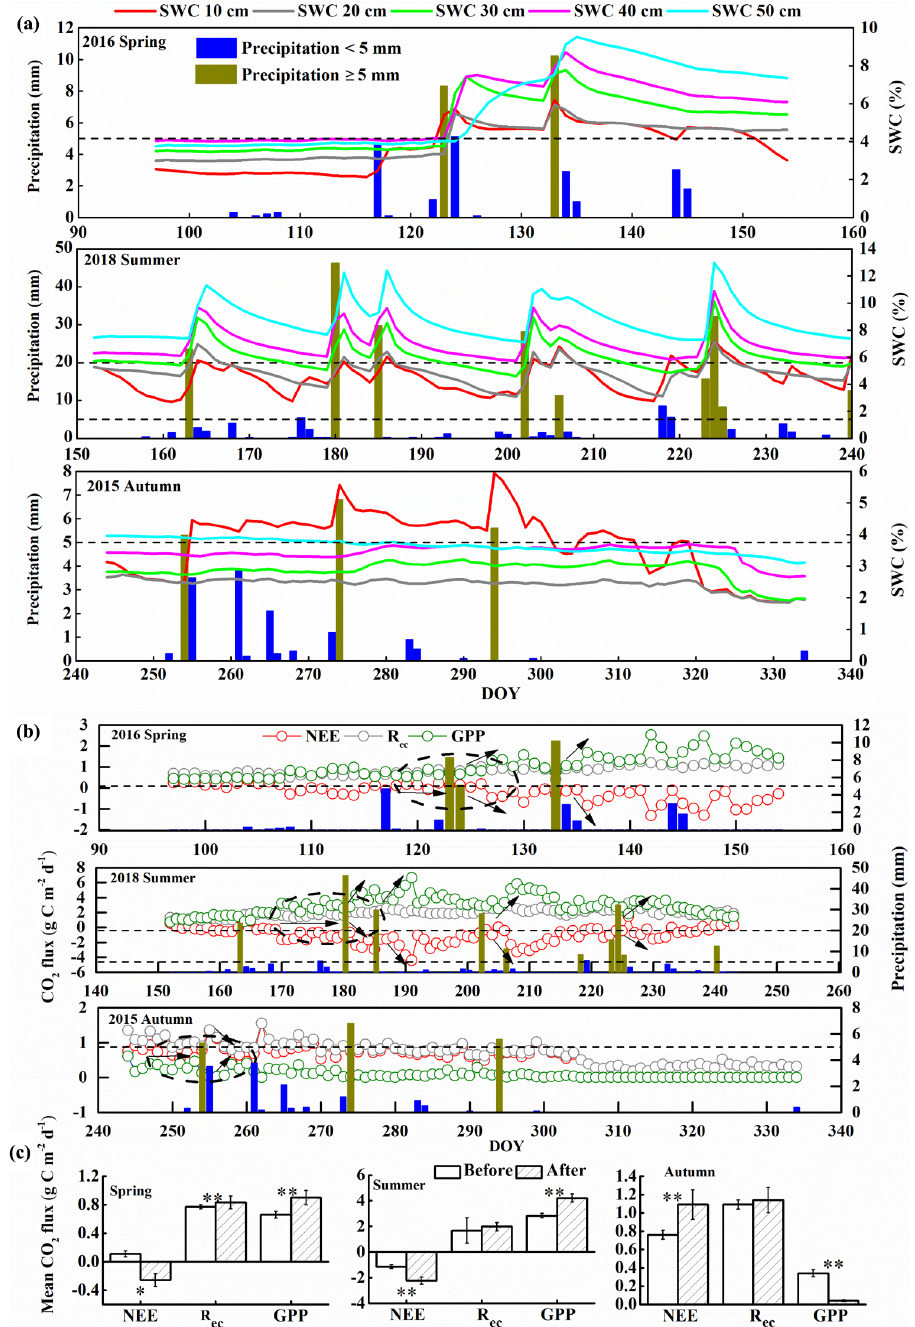
Figure 2. (a) Changes in soil water content (SWC) at depths of 10, 20, 30, 40, and 50cm that resulted from precipitation events in spring, summer, and autumn (DOY, day of year). Precipitation ≥ 5mm represents effective precipitation. (b) Daily net ecosystem exchange (NEE), respiration ( R ec ), and gross primary productivity (GPP) responses to precipitation pulses during the spring of 2016, summer of 2018, and autumn of 2015. The black arrows indicate the trends for carbon fluxes after effective precipitation. (c) Comparison of the mean carbon fluxes before and after effective precipitation pulses based on daily data. We chose the effective precipitation pulses that had no precipitation for 7d after this precipitation (i.e., the period represented by the dashed lines circled in (b) . “Before” values represent the average carbon fluxes for 7d before the precipitation pulse, and “after” values represent the average carbon fluxes for 3 to 5d after the precipitation pulse; the error bars represent standard errors (**, p < 0.01; *, p < 0.05). The horizontal dashed lines in (b) and (c) indicate 5mm of precipitation in spring and autumn and 5 and 20mm in